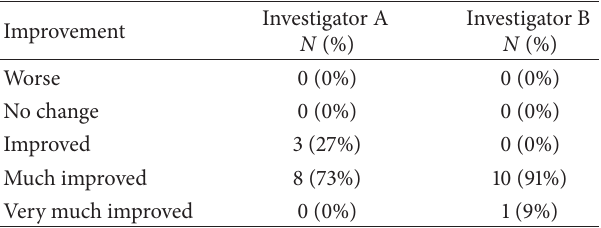
Figure 1: Professional evaluation of clinical improvement for dif- ferent skin parameters. Data are expressed as percentage of patients showing improvement. Table 2: Overall clinical skin improvement evaluation by two separate investigators.